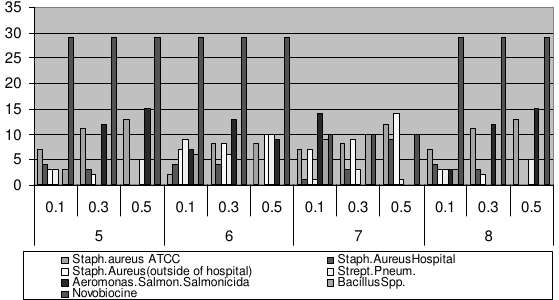
Figure 4. Graphs of microbiological activity results for compounds